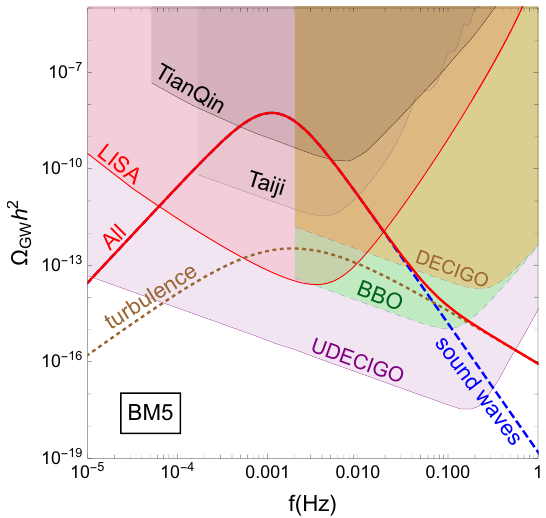
Figure 2 . Gravitational wave energy spectrum for BM5 together with experimentally sensitive regions on the top. See text for more detailed explanations of this